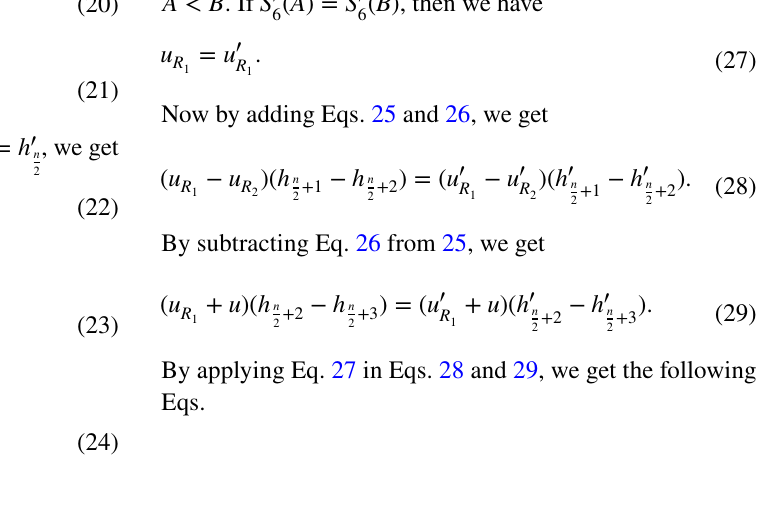
MCDM Table Growth rate of the stock in last 5 years ( C 1